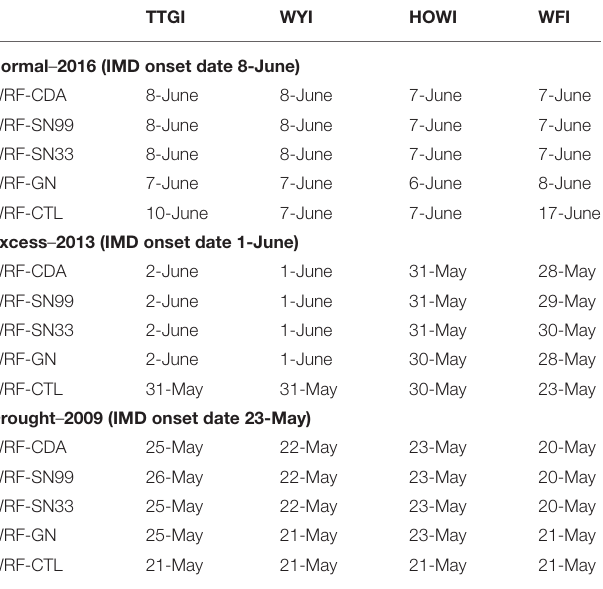
against the corresponding IMD rainfall distributions. The spatial distribution of IMD rainfall during the normal monsoon indicates that India’s west coast and the northeastern parts, followed by central India, receive substantial rainfall of more than 10 mm/day ( Figure 2 , first row). The southern peninsular India (rain shadow region), north and northwest India receive relatively less rainfall of about 5 mm/day. WRF-CTL exhibits a significant dry bias over southern India and relatively less wet bias over the monsoon trough regions. WRF-CTL overestimates the rainfall during the normal monsoon year over central India, with a northward shift, and fails to capture the spatial variability of rainfall over Peninsular India. WRF-GN fails to reproduce these features, with significant wet bias both in terms of distribution and intensity over entire India, except for Jammu and Kashmir. These localized rainfall features are